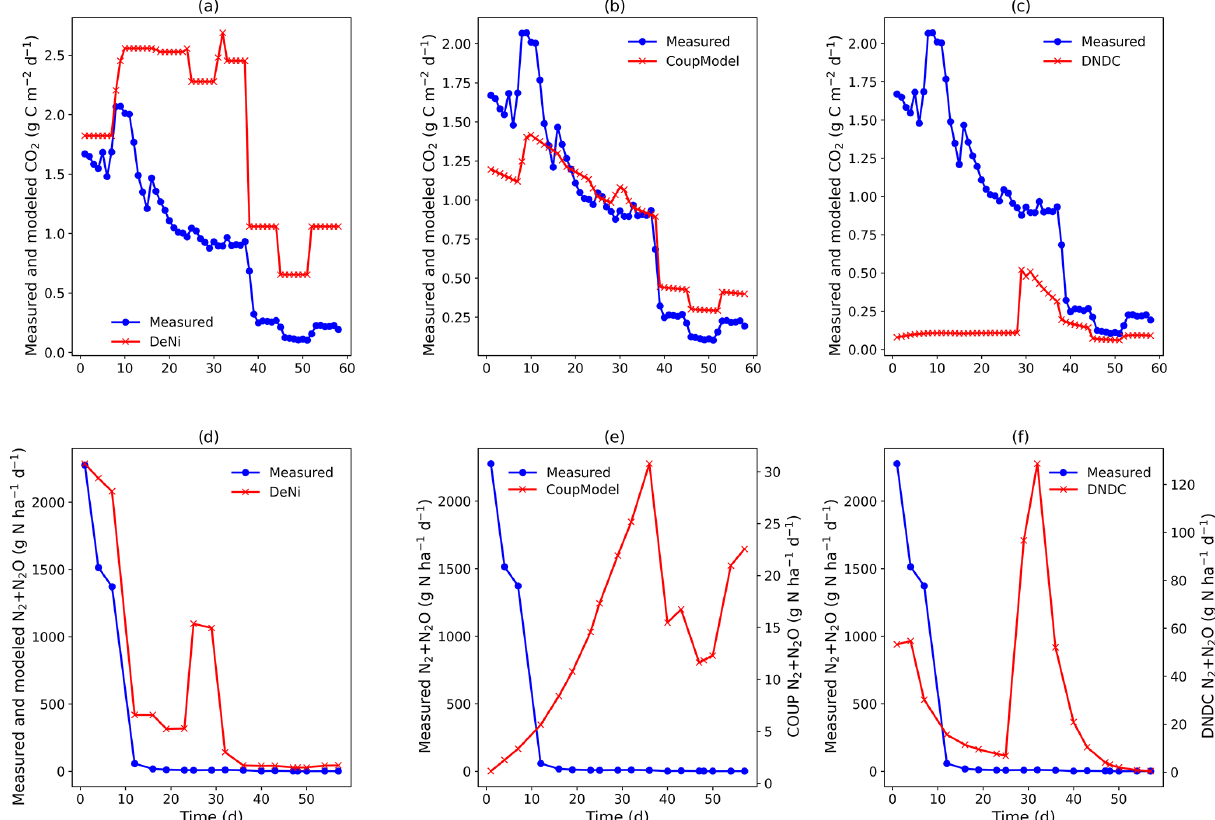
Figure 3. (a–f) Measured and modeled (DeNi, Coup and DNDC) CO 2 and N 2 + N 2 O fluxes from a 58d laboratory incubation of soil cores from a sandy, arable site in Fuhrberg, Germany. Shown is the average of the treated cores (cores 1–4), which were amended with ryegrass prior to incubation. It is important to note the difference in magnitude of the modeled and measured N 2 + N 2 O fluxes ( e and f , secondary y